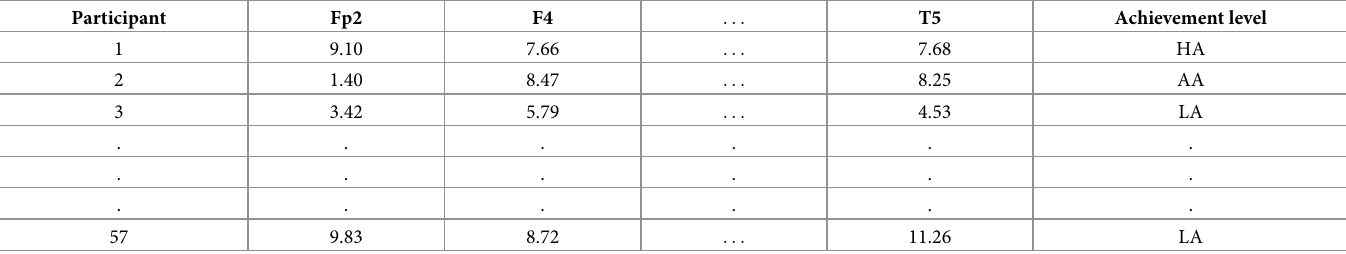
Table 2. Dataset with the values corresponding to the d set is B a G d v